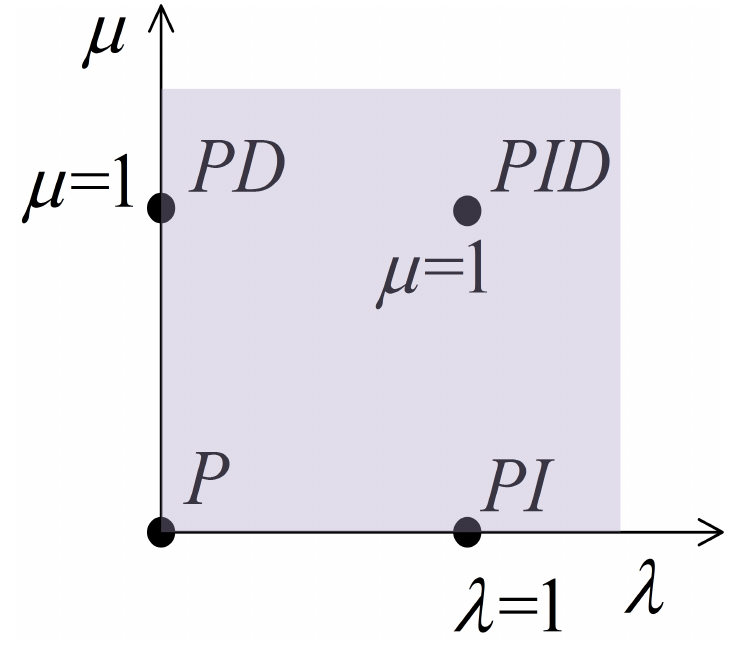
Figure 11. Fractional order PID controller